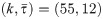
Model parameter search in the second stage.(A) The ratio of the SDs of mean participation coefficient (top) and modularity (bottom) of modeled time-resolved functional connectivity to those of the empirical ones. These ratios were evaluated at the parameter sets extracted in the first stage and their averages over the 100 simulation samples are presented in the heat maps. From the parameter set (k,τ¯)=(55,12), pointed by a white arrow, we obtained the SDs of mean participation coefficient and modularity that were on average closest to those observed in the empirical data. This parameter set was selected for further comparison of the modeled and empirical data. (B) Distributions of the ratio of modeled to empirical fluctuations in mean participation coefficient (top) and modularity (bottom). The distributions obtained from simulations with the actual structural connectivity data are shown in light red and the distributions from the surrogate data are shown in light gray.